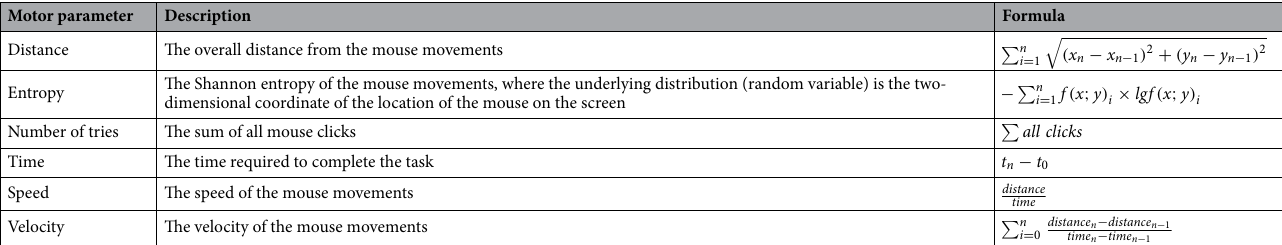
Table 1. Description of mouse movement parameters. x and y refer to x and y coordinates of the screen, while t refers to